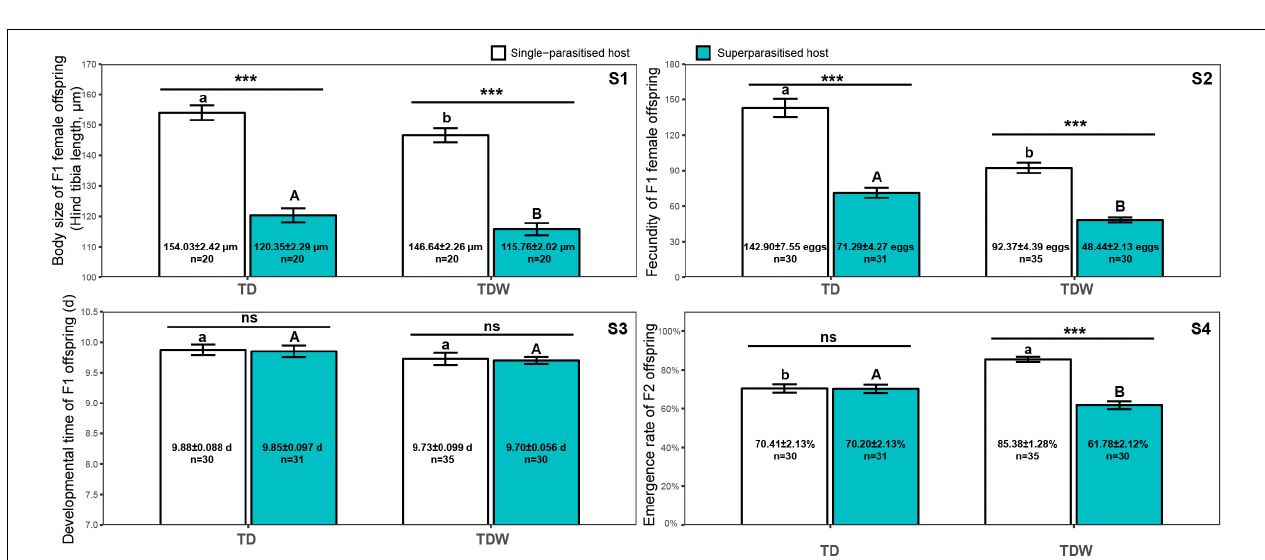
FIGURE 2 | Body size of F1 female offspring (S1) , fecundity of F1 female offspring (S2) , developmental time of F1 offspring (S3) , and emergence rate of F2 offspring (S4) of TDW or TD line in superparasitised (cyan bars) or single-parasitised (white bars) hosts. Bars indicate Means. Error bars indicate the interval of Mean ± Standard Error. The different uppercase letters indicate significant difference between TD and TDW in superparasitised hosts. The different lowercase letters indicate significant difference between TD and TDW in single-parasitised hosts. “ns” or “***” indicates non-significant difference or significant difference at P < 0.001, respectively, between superparasitised hosts and single-parasitised hosts. Texts labeled on the bars indicate sample size and values of Mean ± Standard Error.